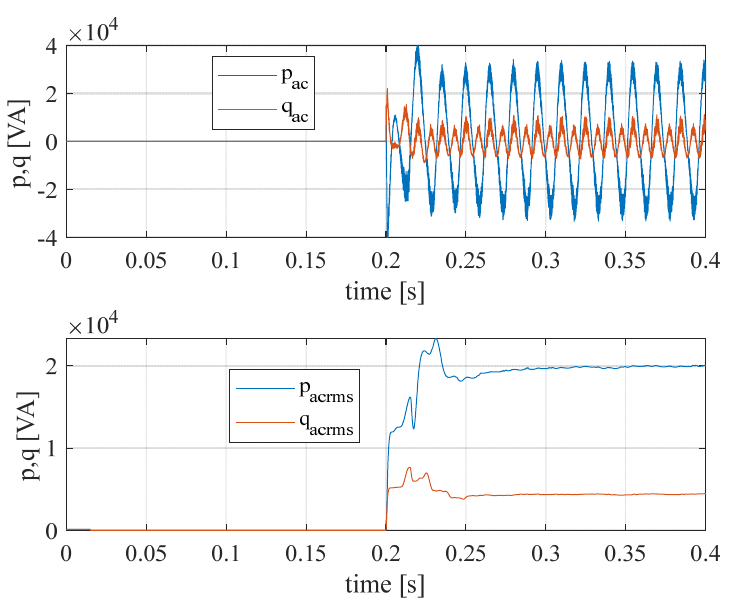
Figure 15. Active and reactive power during compensation of ICE engine torque oscillations.